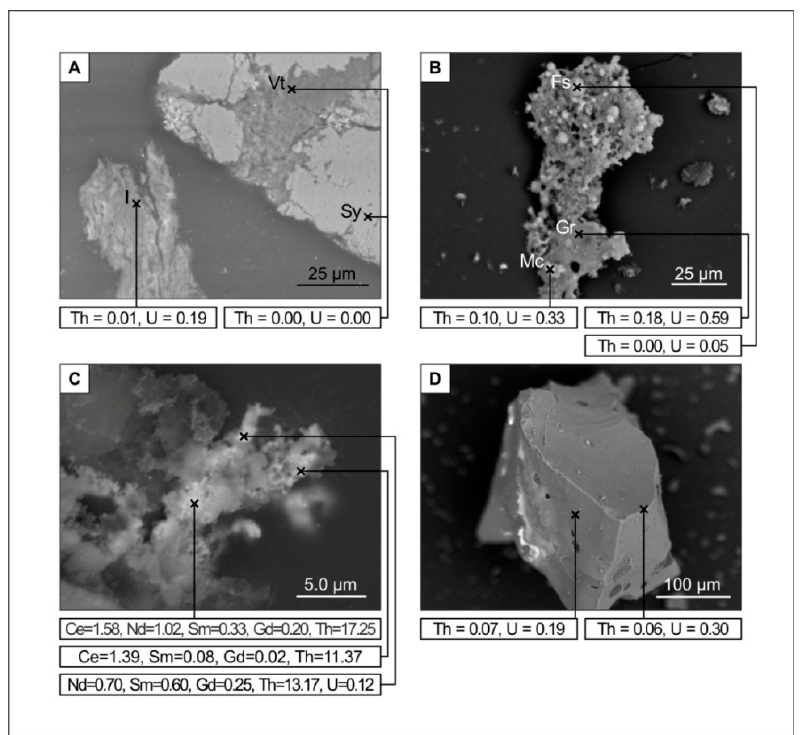
Figure 2. Sample results of the SEM/EDS analysis of U and Th content in: ( A ) inertinite (I), vitrinite (Vt) and siderite (Sy) in feed coal; ( B ) ferrosphere (Fs), Al-Si porous grain (Gr) and magnetite microcrystal (Mc) in fly ash <0.05 mm; ( C ) monazite in fly ash <0.05 mm; ( D ) Al-Si massive grain in slag.